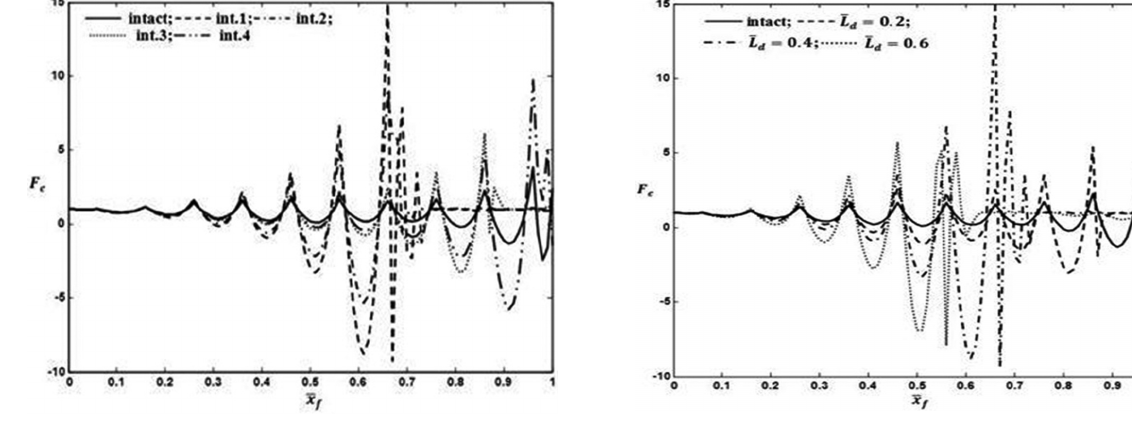
(cid:6) L 1 = 0 . 3 ,L d = 0 . 4